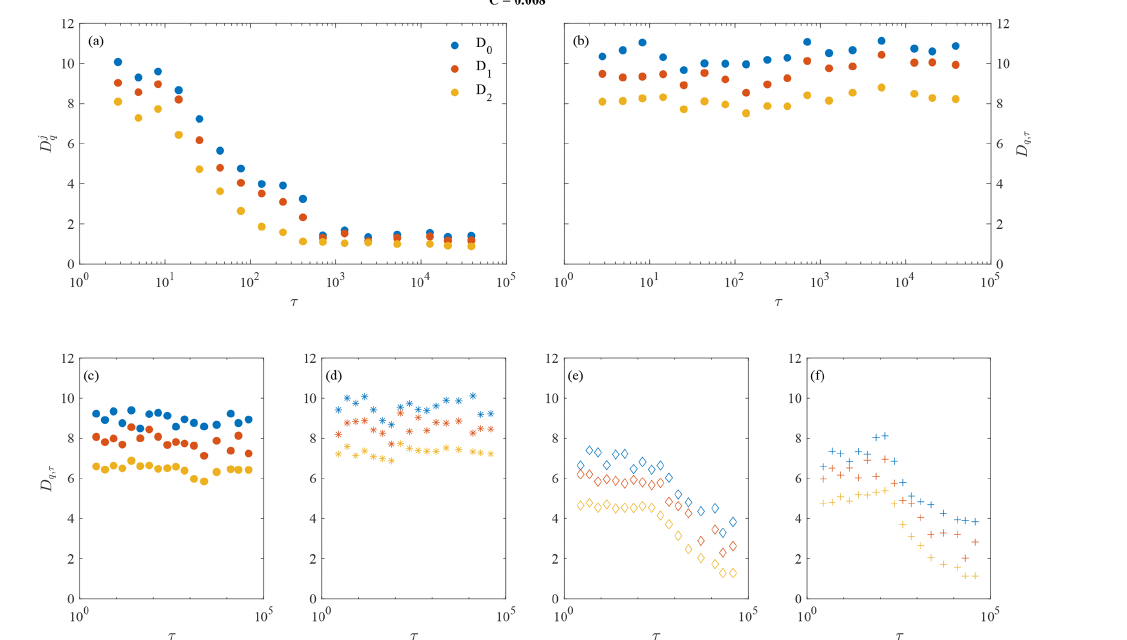
Figure 7. Multiscale capacity dimension D 0 ,τ , multiscale information dimension D 1 ,τ , and multiscale correlation dimension D 2 ,τ for C = 0 . 008 at different timescales τ j for different cases: (a) for each MIMF individually ( D j q ), (b) for reconstructions of MIMFs as in Eq. (12) ( D q,τ ), and (c–f) for reconstructions of MIMFs separately for each variable (barotropic modes – c , baroclinic modes – d , transport modes – e , and temperature modes – f